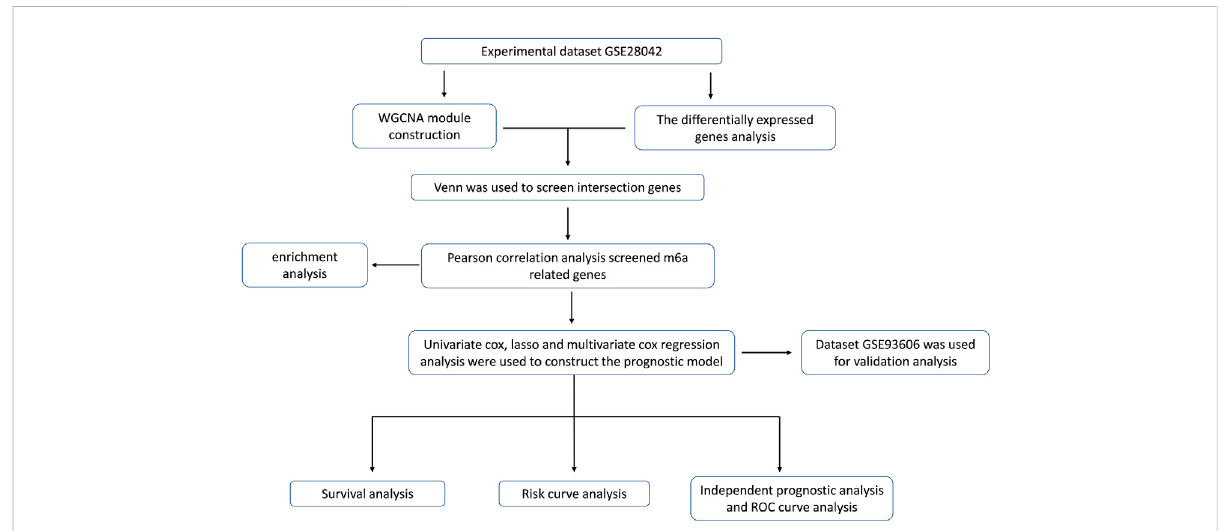
FIGURE 1 The work fl ow for prognostic analysis of m6A-related genes as potential biomarkers for idiopathic pulmonary fi